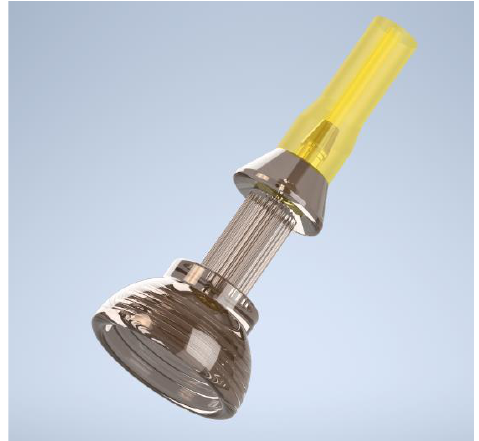
Figure 1. Prototype #2 of THD produced with stainless steel. The conical end is doom shaped for optimal contact with the tissue, the upper pole is designed to firmly connect with a hose. The inner bore at the level of the hose connection was widened to 1.8 mm, and the retention grid was removed.